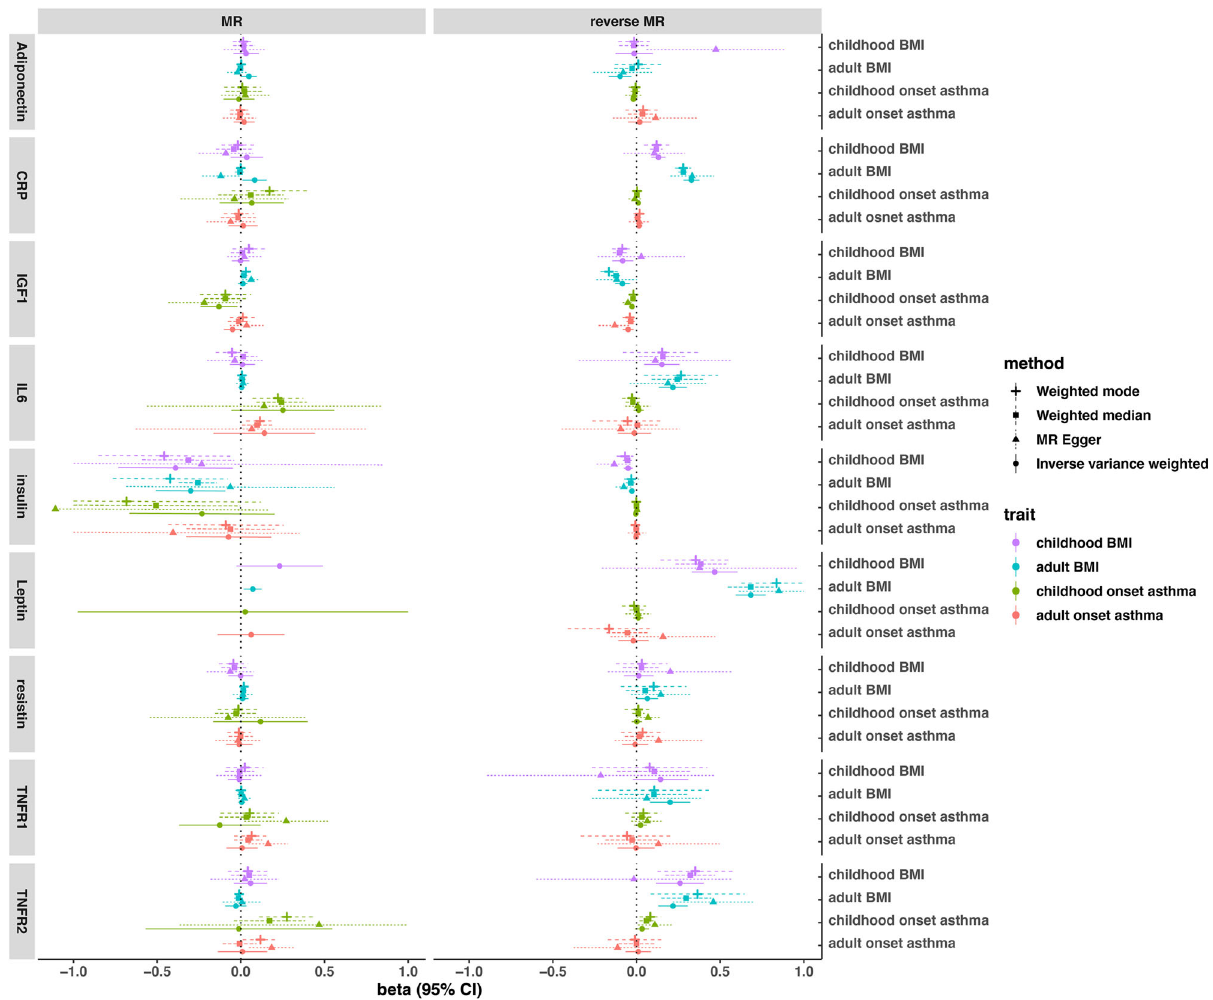
Fig. 6 Bi-directional Mendelian randomization estimates of the association between asthma, BMI, and obesity-related biomarkers in children and adults. The MR panel shows the effects of obesity-related biomarkers (exposures) on risk of BMI and asthma (outcomes) in children and adults. The reverse MR panel shows the effects of BMI and asthma on obesity-related biomarkers (reverse-directional MR analysis). Different Mendelian randomization methods are displayed in different line types. For the binary exposures (childhood and adult asthma in the reverse MR analysis), MR estimates here are only used to evaluate evidence for causality and the consistency of direction of effect. The interpretation of effect sizes for binary exposures needs more